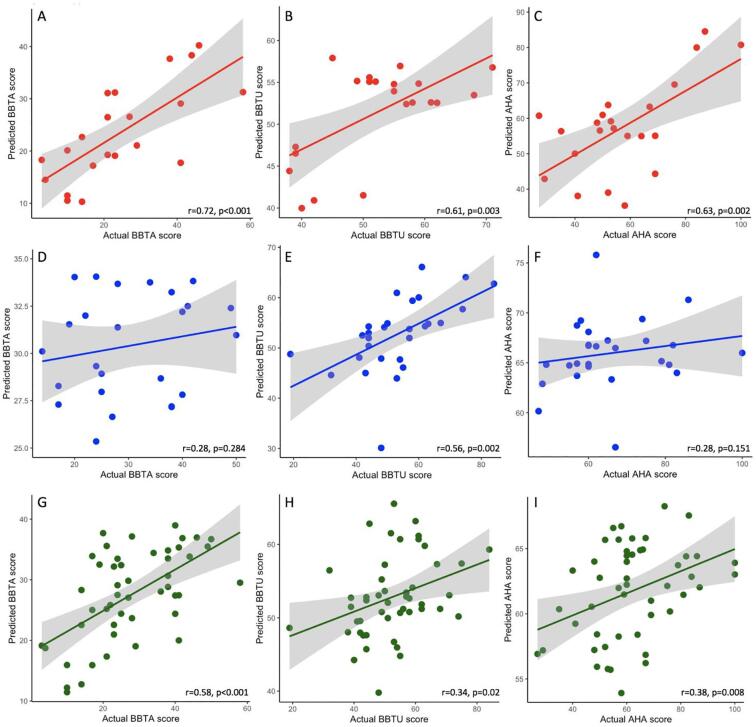
Regression models represented as scatterplots illustrating relationships between predicted and actual scores for motor outcomes on the BBTA, BBTU and AHA for (A-C) AIS, (D-F) PVI and (G-I) AIS + PVI groups combined. Shaded areas represent 95% confidence intervals of the regression line. AIS – Arterial ischemic stroke, PVI – periventricular infarction, TDC – Typically developing controls, BBT – Box and Blocks Test (BBTA - Affected hand, BBTU – Unaffected hand), AHA – Assisting Hand Assessment.